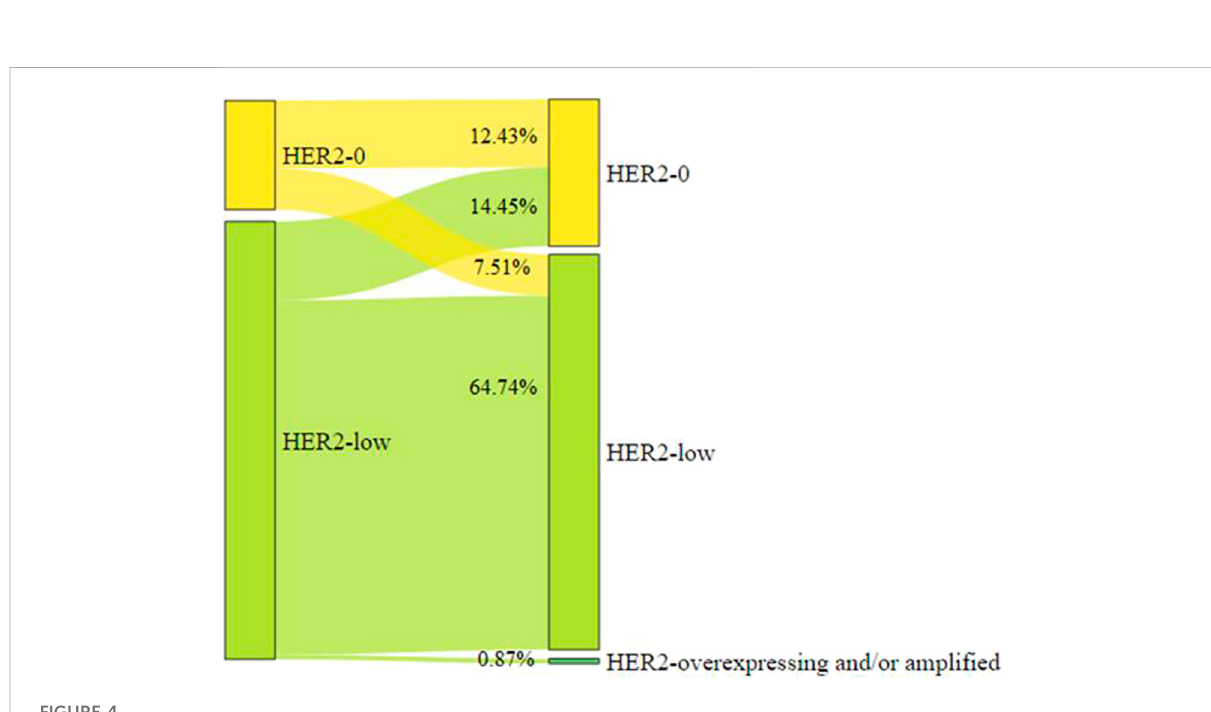
FIGURE 4 Evolution of HER2 status before and after neoadjuvant